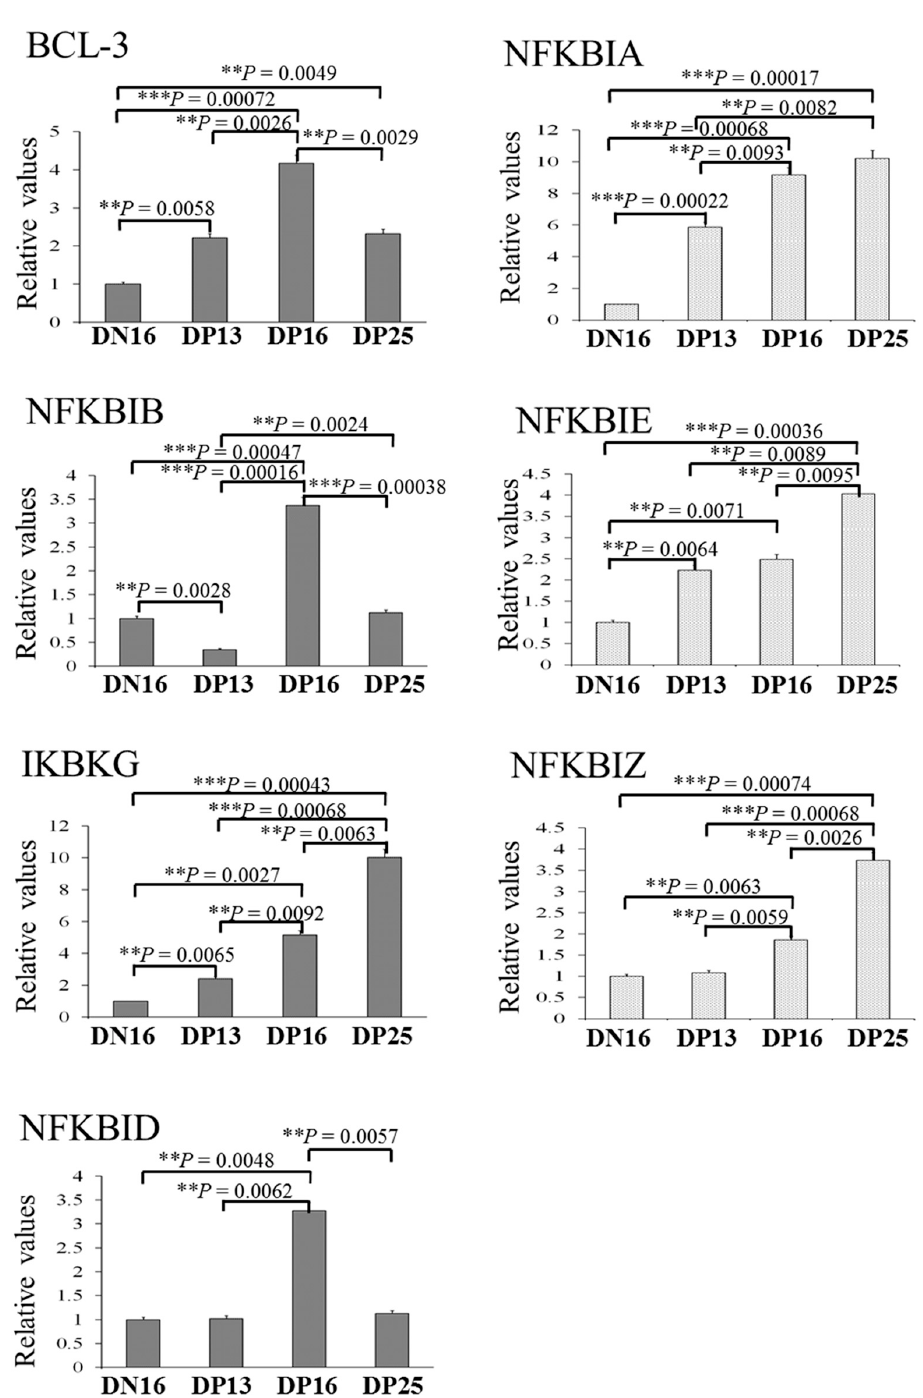
Figure 1. Relative expression values of BCL-3 , NFKBIA , NFKBIB , NFKBIE , IKBKG , NFKBID and NFKBIZ mRNA in ovine spleen measured by quantitative real-time PCR. Note: DN16 = day 16 of the estrous cycle; DP13 = day 13 of pregnancy; DP16 = day 16 of pregnancy; DP25 = day 25 of pregnancy. Significant differences ( p < 0.05) are indicated by different letters within same color columns. p values between 0.001 and 0.01 are shown with two (**) asterisks, and p value less than 0.001 is designated with three (***) asterisks.